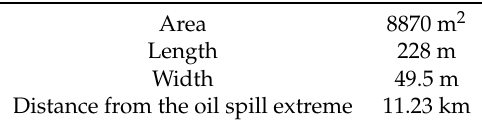
Table 3. Features of the potential responsible